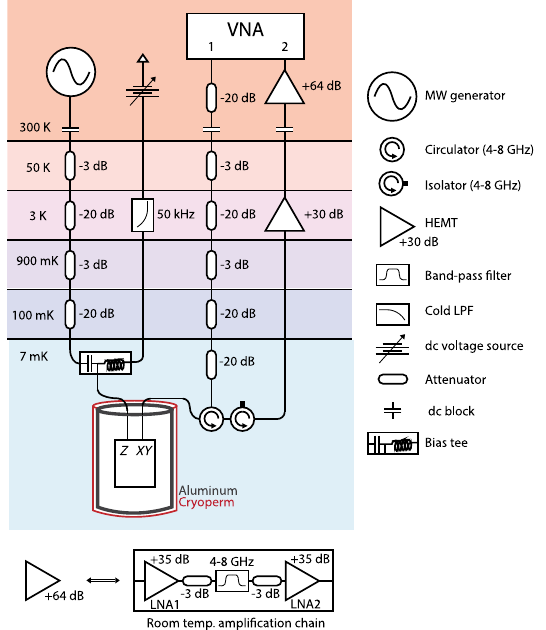
FIG. 8. Experimental setup schematic. The sample is placed inside a multilayer magnetic shield [2.5-mm-thick aluminum and 1-mm-thick Cryoperm (MuShield, Inc.)] at the mixing chamber plate of a dilution refrigerator with base temperature T ≈ 7 mK. The measurement and control electronics for probing the scatter- ing parameters and applying a flux bias are